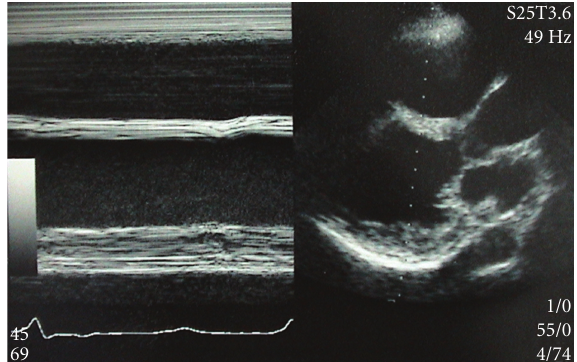
Figure 1: Echocardiography shows biventricular enlargement and di ff use hypokinesis of the left ventricle without wall thinning.